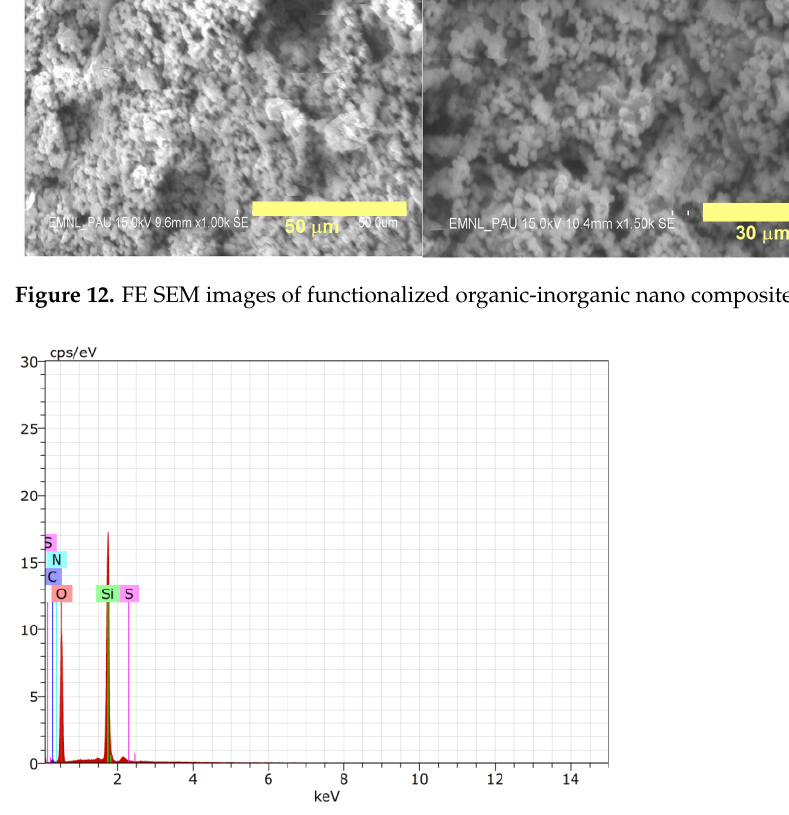
Figure 12. FE SEM images of functionalized organic-inorganic nano composites (11) .